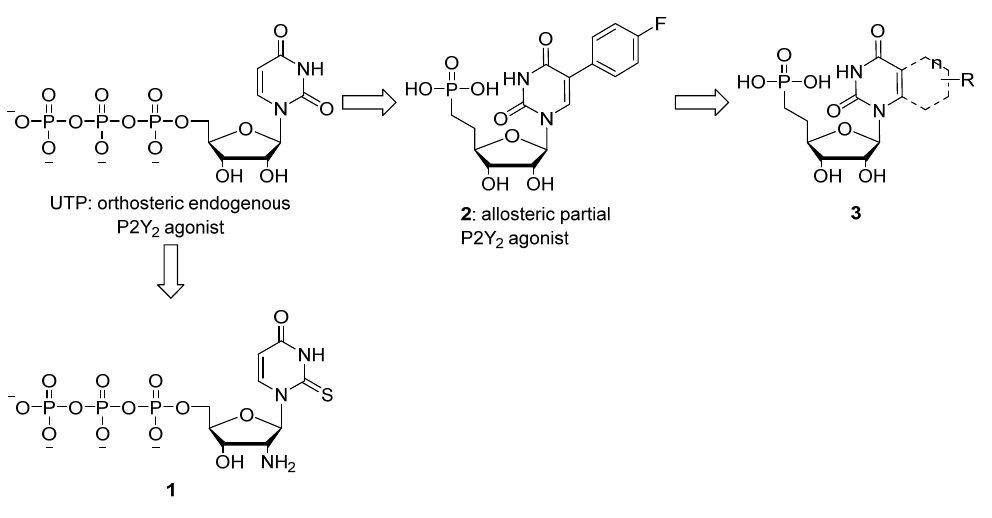
agonist 1 , the allosteric partial agonist 2 2